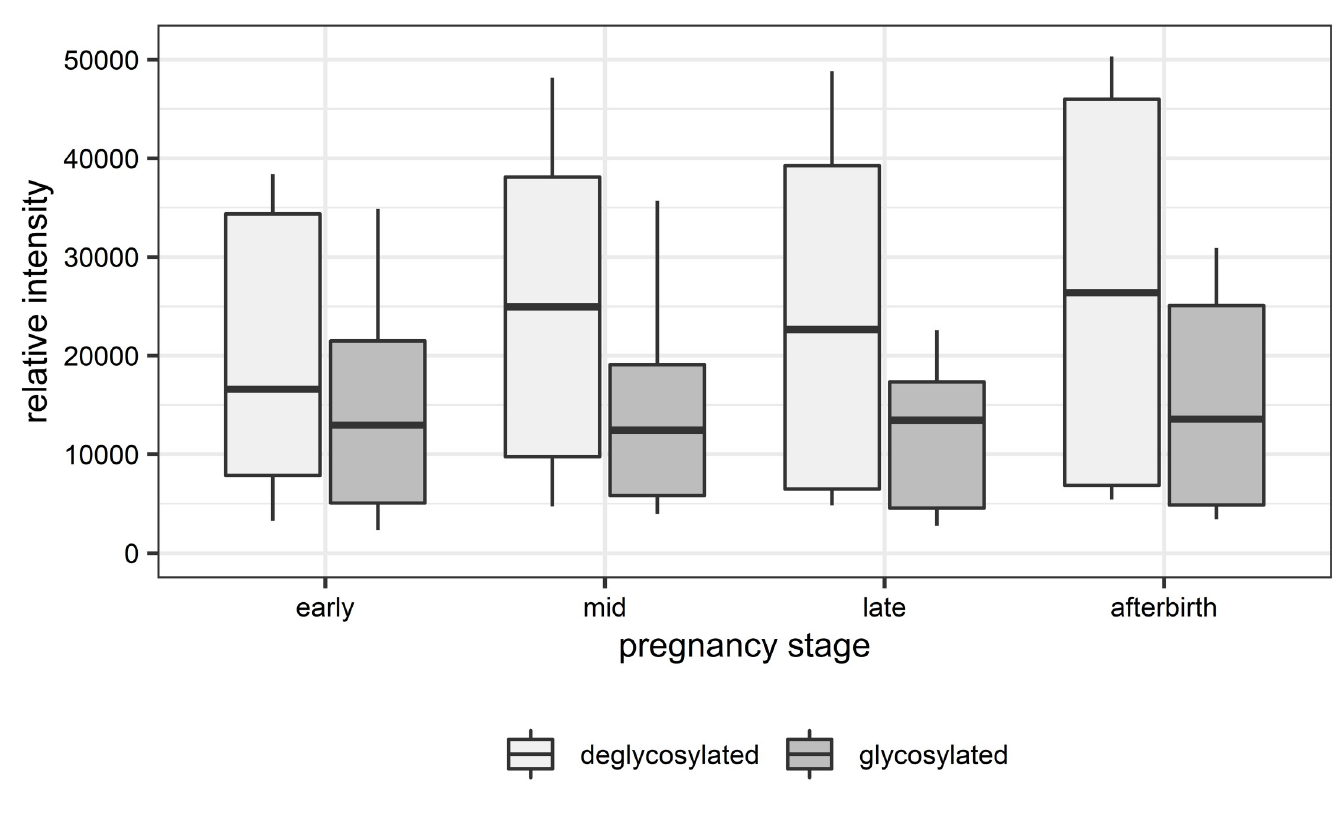
Fig 6. Overview of the results from Western blot analyses. Box-and-whisker plot visualization represents the intensities of the fluorescence signal.